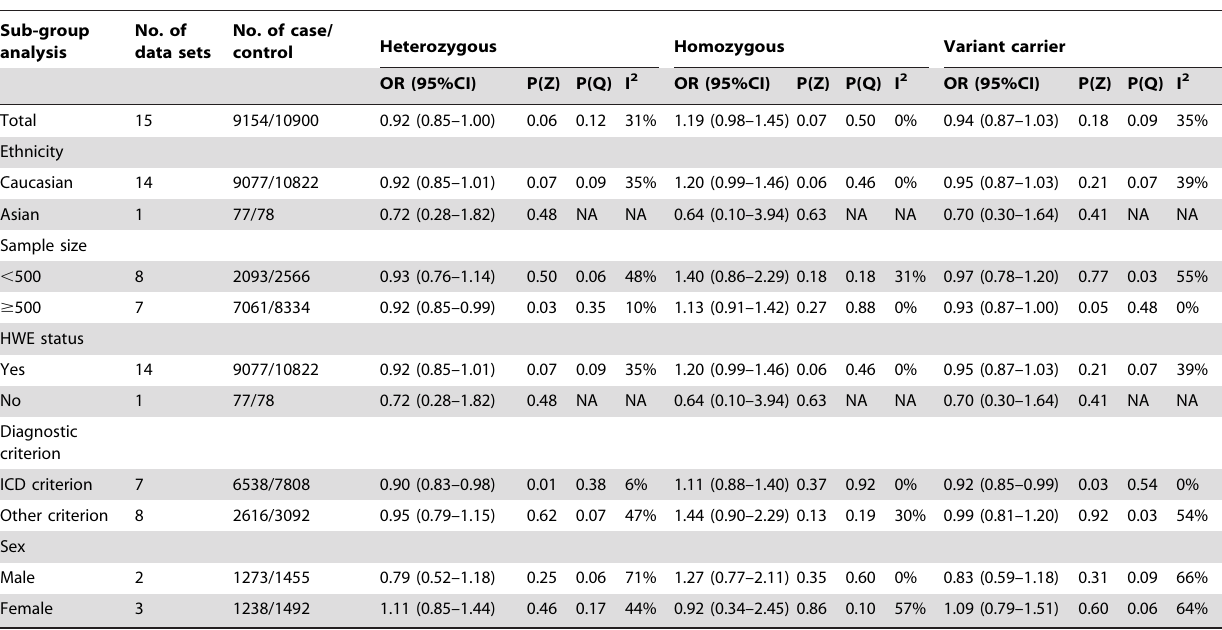
Table 2. Meta-analysis of the CYP2C9 *2 polymorphism on colorectal cancer susceptibility.